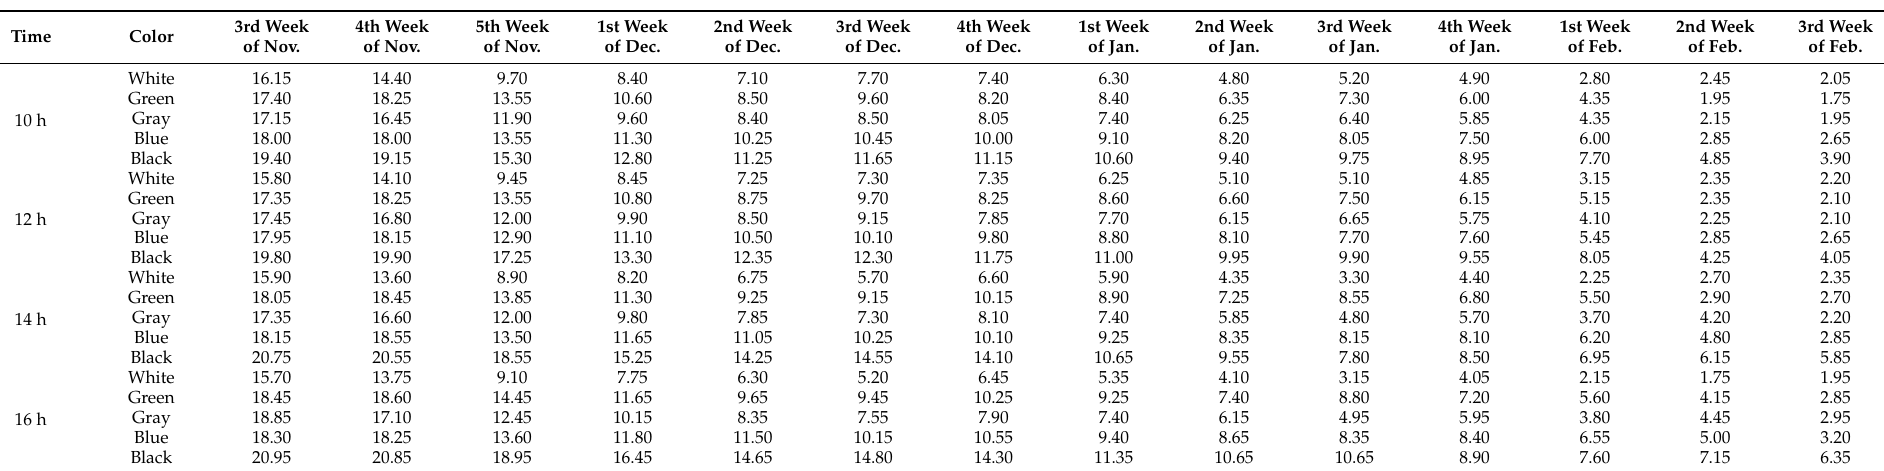
Table 5. Weekly indoor average temperatures acquired by a thermometer at different times ( ◦